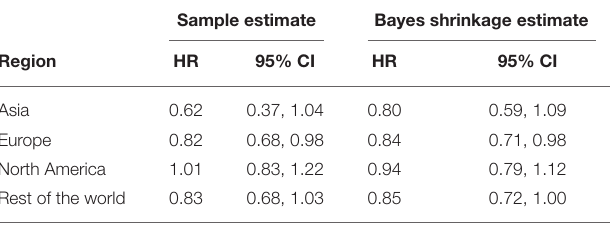
Regional sample estimates obtained from a Cox regression model with treatment, region, and its interaction with treatment. CI, confidence interval; HR, hazard ratio; MACE, major adverse cardiovascular